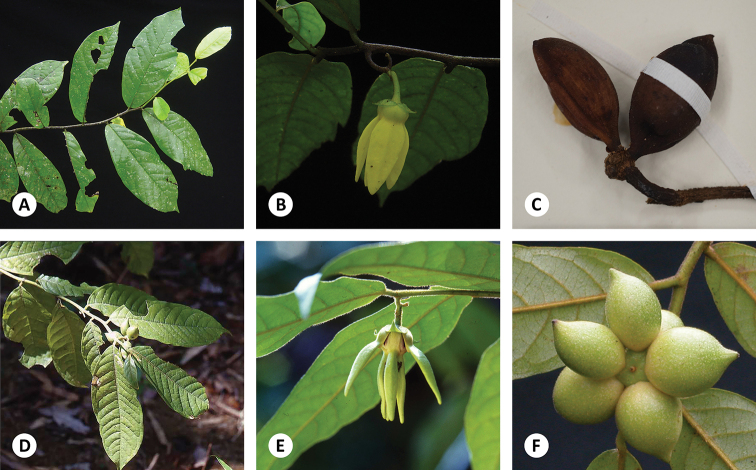
A–CArtabotrys
insurae sp. nov. A habit (T. Insura 58) B flower, showing flat petal blades (T. Insura 58) C fruit, showing weakly beaked monocarps with distinct stipes (D.J. Middleton et al. 1487) D–FArtabotrys
uniflorusD habit E flower, showing three-angled petal blades F fruit, showing strongly beaked monocarps that are sessile. Photos: A, B T. Insura C D.M. Johnson D–F P. Chalermglin.